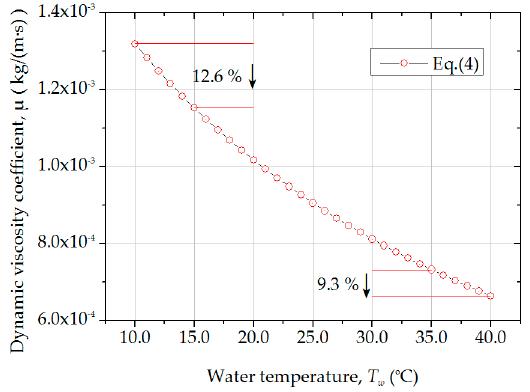
Figure 3. Water dynamic viscosity coefficient vs. water temperature.